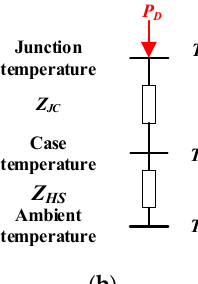
The thermal network in the healthy module is shown in Figure 2b. The power loss of die transfers through the IGBT module Z JC and heatsink Z HS to the ambient. Hence, the measured thermal resistance of heatsink could be obtained based on (3), which equals the theoretical value of equivalent thermal resistance of heatsink Z E _ HS on the case point.